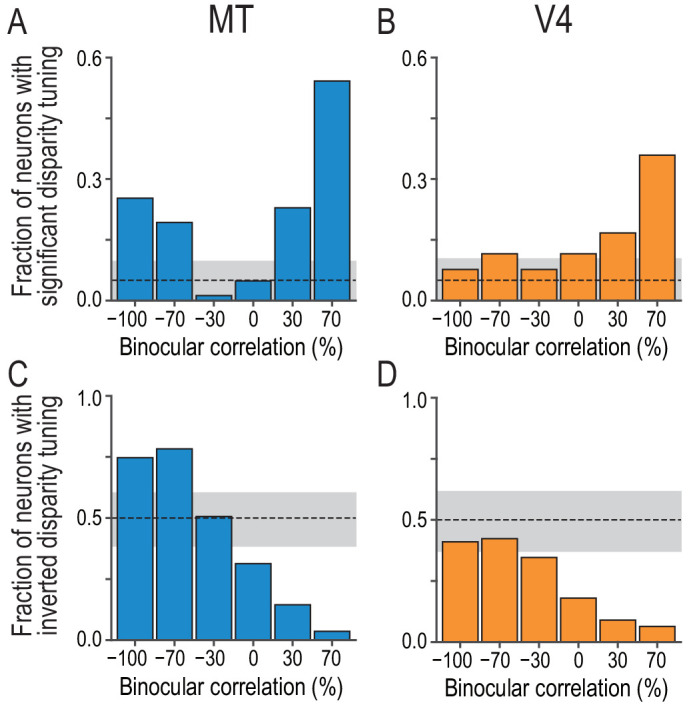
Fractions of neurons with significant and inverted disparity tuning show different dependencies on graded anticorrelation between MT and V4.(A and B) The fraction of neurons with significant disparity tuning as a function of binocular correlation (Kruskal–Wallis test; p<0.05). The population comprises all recoded neurons with significant tuning at 100% correlation (83 and 78 neurons for MT and V4, respectively). The dashed line indicates the chance level and the gray area indicates its 95% interval based on the binomial distribution. The fraction at 100% correlation is one by definition. (C and D) The fraction of neurons with inverted disparity tuning (relative to the tuning to cRDSs) as a function of binocular correlation. Negative tuning correlation was considered to indicate tuning inversion. The same populations as in (A and B) were analyzed. (See Figure 3—figure supplement 1 for the same analysis applied to the subpopulations of tuning curves without significant selectivity; we suggest that the supplementary results warrant the inclusion of non-selective tuning in this main analysis.) The chance level is 0.5. The fraction at 100% correlation is zero by definition.Figure 3—source data 1.The p-values for Kruskal–Wallis test to assess disparity selectivity and tuning-curve correlation to assess tuning inversion at each binocular-correlation level.